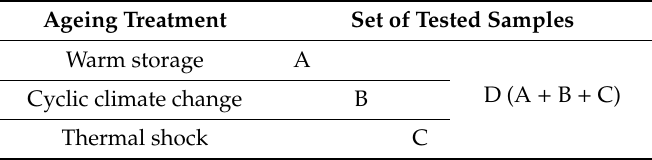
Table 6. Tested samples after di ff erent ageing treatments.